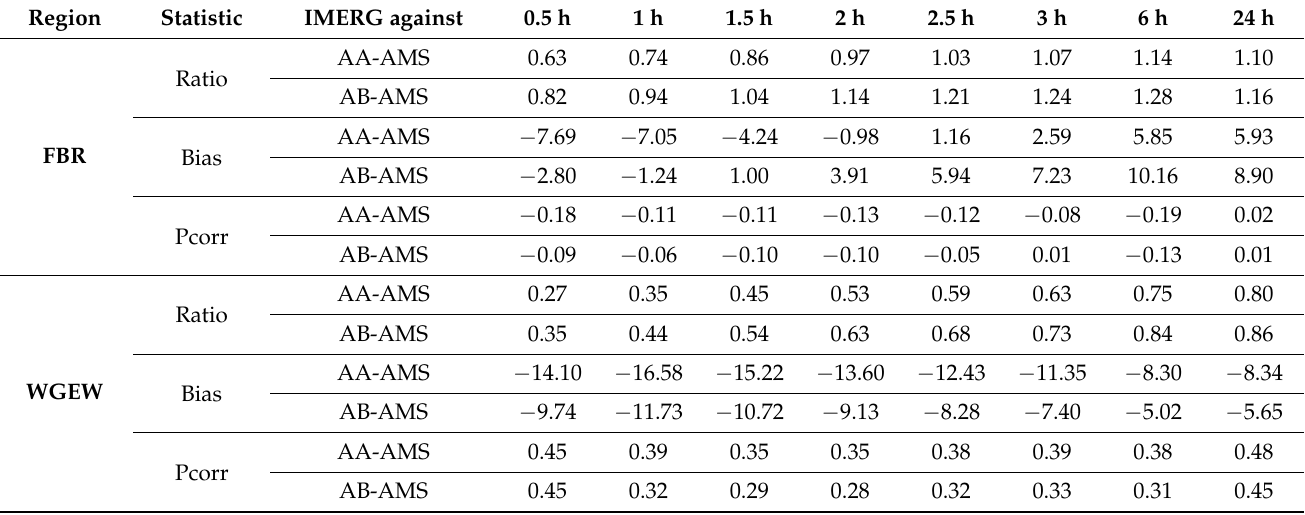
Table 4. Ratio, bias, and Pearson correlation of IMERG AMS against gauge-based AMS for